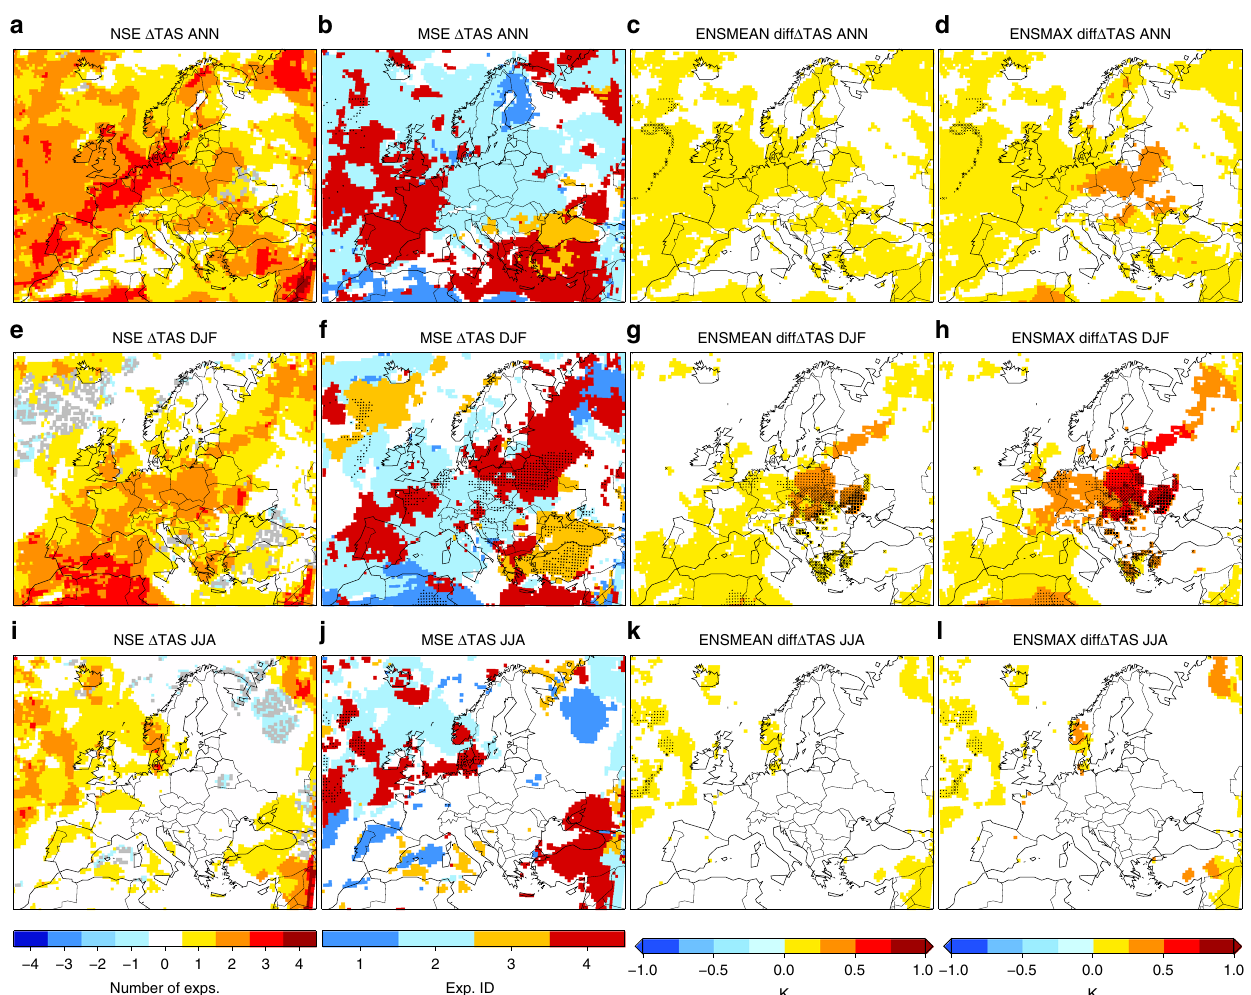
Fig. 3 Sensitivity of near-surface air temperature projections to the GHG handling in an ensemble of regional simulations. Number of sensitive experiments (NSE, fi rst column, panels a , e , i ) and most sensitive experiment (MSE, second column, panels b , f , j , numbers referred to the experiments identi fi ers of Table 1), within the ensemble of WRF runs (Table 1), to the GHG handling by the RCM when projecting TAS changes under 1.5°C global warming ( Δ TAS, assessed at annual, DJF and JJA scales in fi rst, second and third rows, respectively). The NSE is computed by assigning 1 to those experiments in which the varying GHG approach provides signi fi cantly ( p < 0.1) higher values of Δ TAS than the constant GHG approach, − 1 to those in which Δ TAS is signi fi cantly lower in the varying GHG counterpart of each experiment, 0 if there is no signi fi cant difference between both approaches, and then summing over the four experiments; with the color gray indicating the mix of 1 and − 1. MSE denotes the experiment in which the difference in Δ TAS between approaches is highest if it is statistically signi fi cant; if not, it is white. The points in the second column indicate that Δ TAS in the MSE is at least double when GHG vary. The third and fourth columns (panels c , g , k , and d , h , l ) depict, respectively, the ensemble mean and maximum values of the differences in Δ TAS (units: K) between approaches over the grid points in which at least two experiments provide signi fi cant values of such differences; otherwise, it is white. The points, crosses, stars, and squares in the third and fourth columns indicate that Δ TAS is at least double when GHG vary in one, two, three, or four experiments,